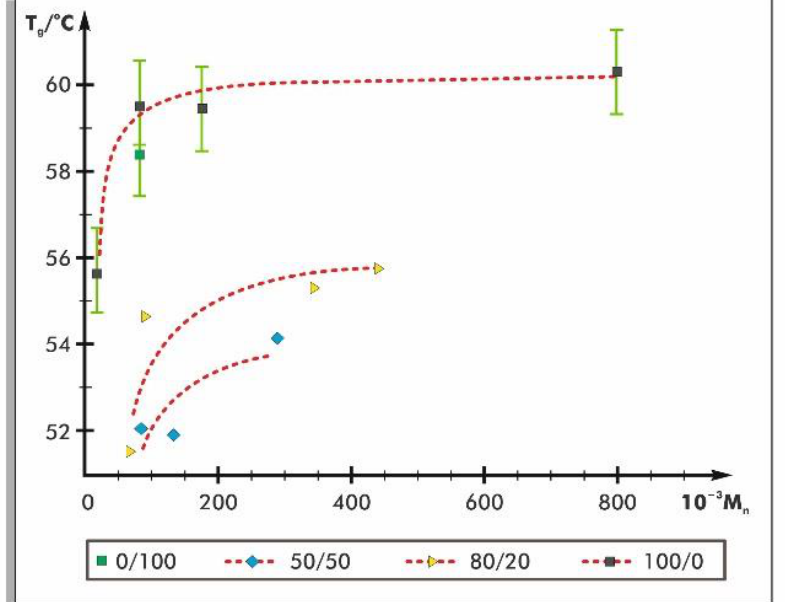
Figure 5. Glass transition temperatures (T g ) of PLA polymers with different L -stereoisomer contents as a function of number-average molecular weights (M n ). Symbols on the legend represent the L / D -isomers ratios [20].